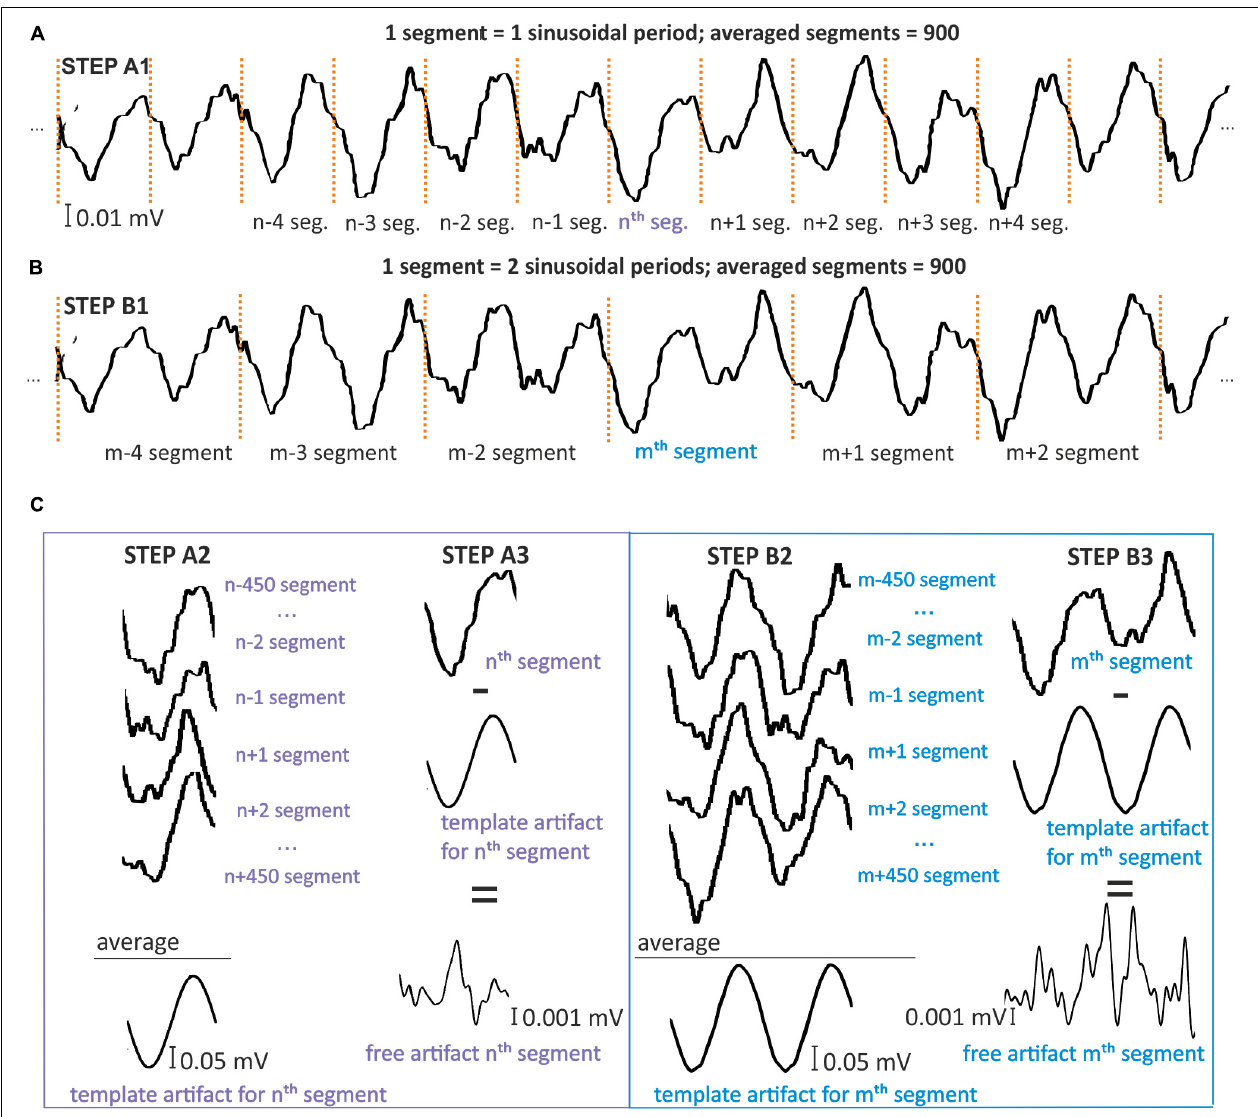
FIGURE 4 | Model for simple moving average filtration for 1- (A) and 2-period (B) segments. Simulation was prepared on signal STEP A1, B1, by dividing the signal for one or two period segments [s(n) and s(m)]. STEP A2, B2: To create an artifact template for the nth or mth segment, 900 other segments were selected that centered around the considered segments. The samples in the same phase were then averaged by columns. STEP A3,B3: The resulting artifact templates were then subtracted from the nth and mth segments that included artifact. This subtraction results in nth and mth segments that are free of